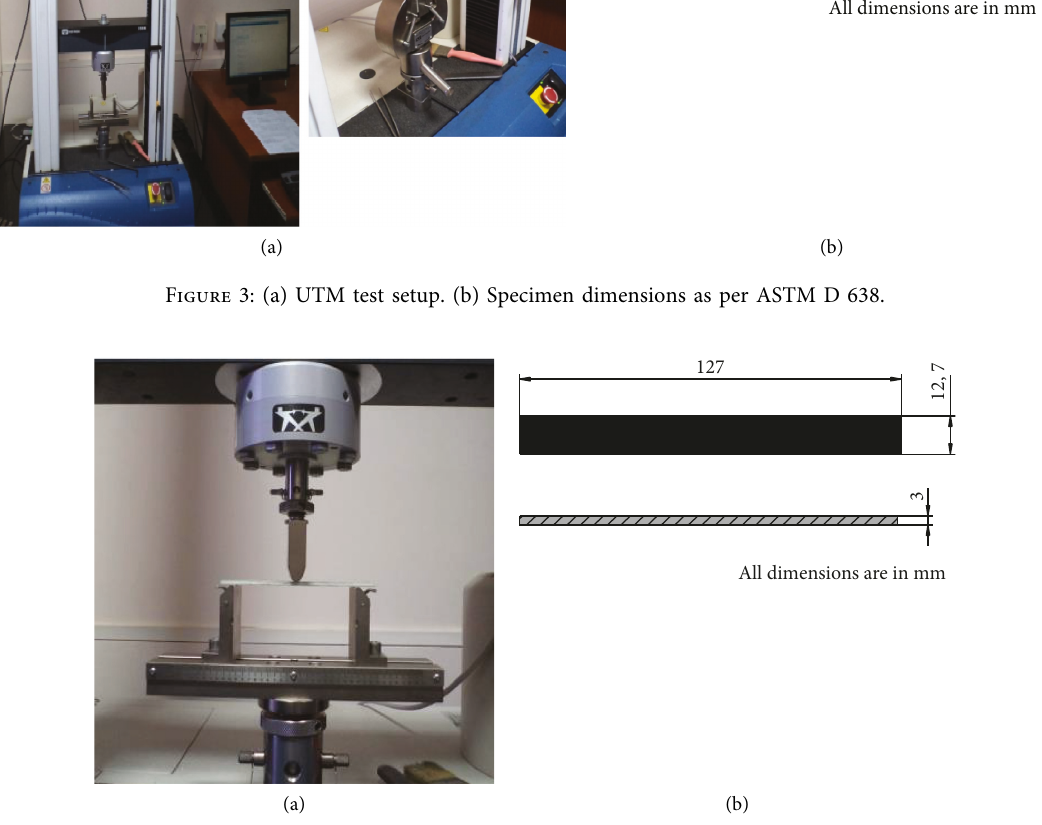
Figure 4: (a) Three point bending test setup. (b) Specimen dimensions as per ASTM D